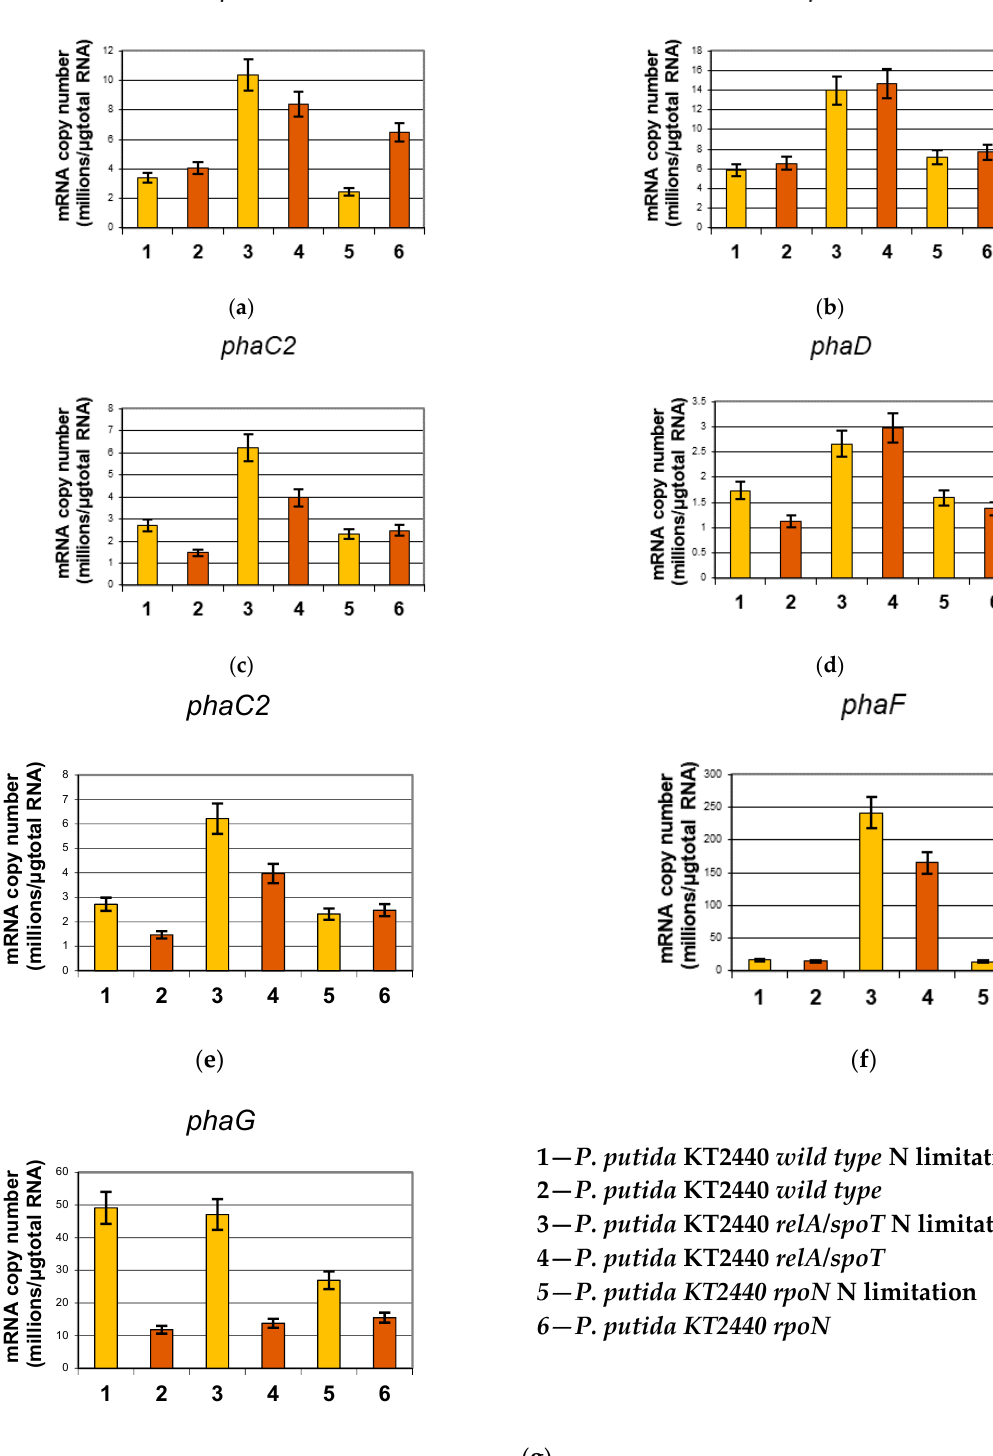
Figure 3. The results of quantitative real ‐ time reverse transcription PCR analysis of phaC1 ( a ), phaZ ( b ), phaC2 ( c ), phaD ( d ), phaI ( e ), phaF ( f ) , and phaG ( g ) gene expression. Samples were taken at 48 h of cultivation. All analyzed strains were cultivated in shake flasks under optimal and nitrogen limiting conditions. Mean values with standard deviations are shown ( n = 3). 1— P. putida KT2440 wild type N limitation; 2— P. putida KT2440 wild type; 3— P. putida KT2440 relA / spoT N limitation; 4— P. putida KT2440 relA / spoT ; 5— P. putida KT2440 rpoN N limitation; 6— P. putida KT2440 rpoN.